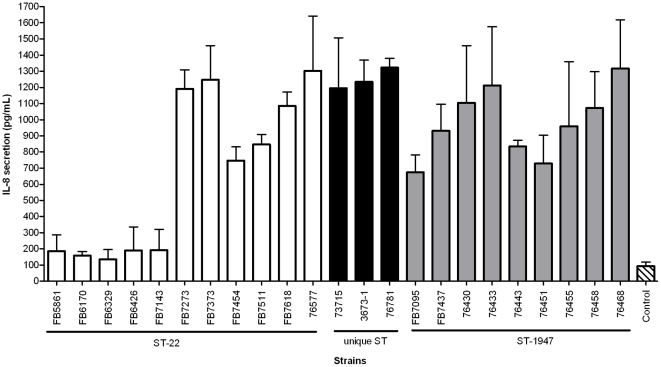
IL-8 secretion induced from Campylobacter jejuni-HeLa cells co-culture after 24h of incubation.White bars represent ST-22 strains, black bars represent unique ST (1966, 3892 and 3996, respectively) and gray bars represent strains with ST-1947. The control (or basal level of IL-8 secretion by HeLa cells) is represented by the striped bar. The difference between ST groups was not significant (p>0.05). Five strains belonging to the ST-22 (FB5861, FB6170, FB6329, FB6426 and FB7143) promoted significantly lower IL-8 secretion on HeLa cells than the other strains with ST-22, ST-1947 and unique STs (p<0.001). The four chicken strains were not done. Data are presented as mean ± SEM.